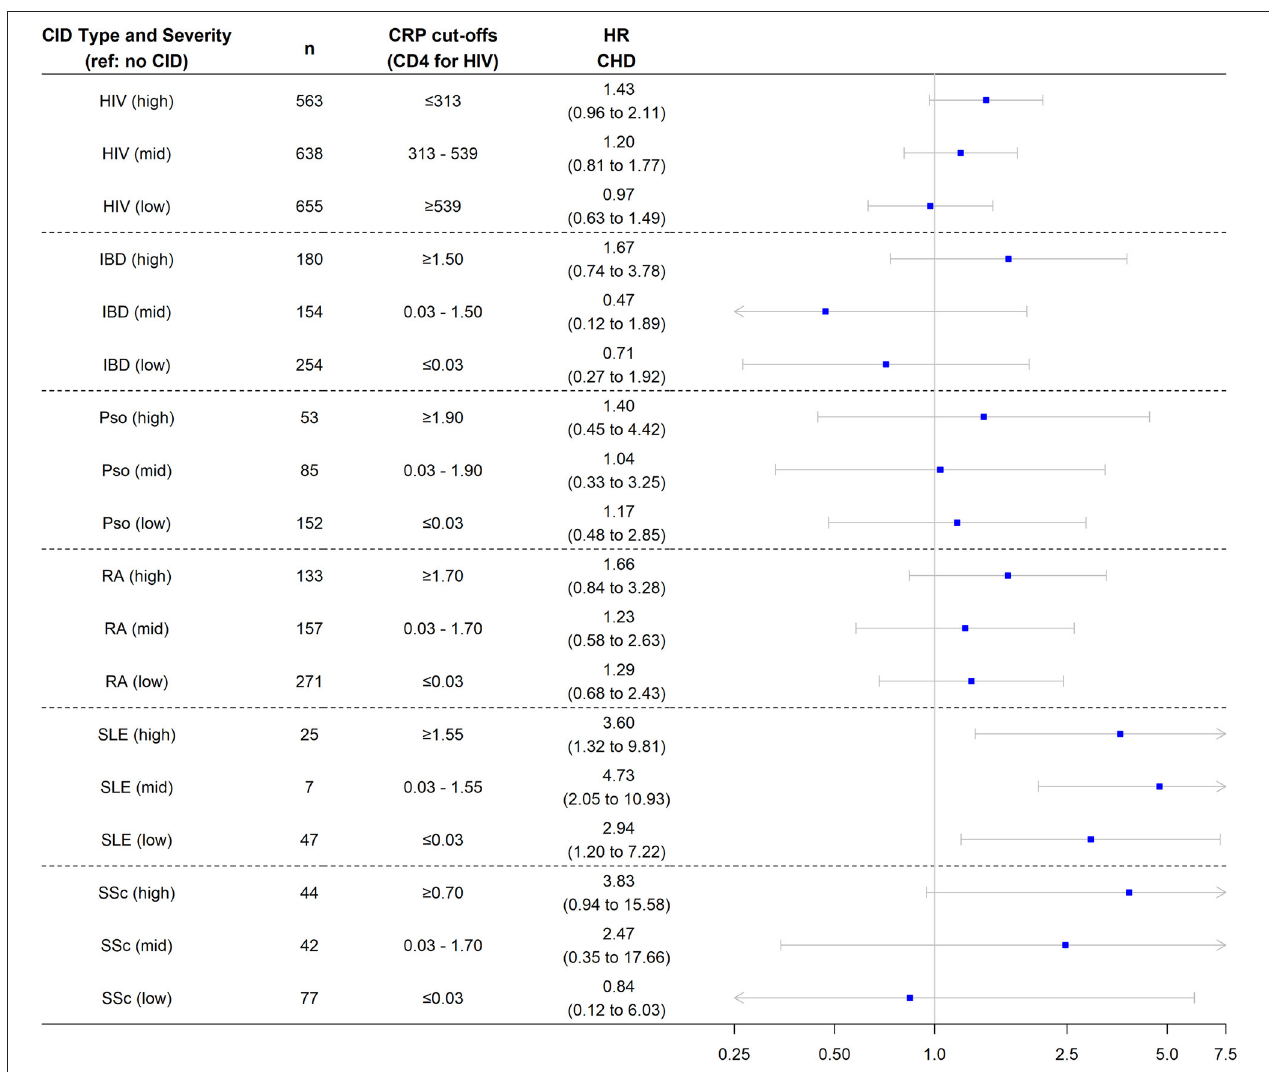
FIGURE 3 | Risk of incident coronary heart disease among chronic inflammatory disease groups stratified by disease severity. Analysis performed in nested cohort. Cox proportional hazard ratios adjusted for age, sex, race/ethnicity, insurance, baseline year, hypertension, diabetes, current smoking, total cholesterol, statin use, and systemic steroid use. CHD, coronary heart disease; HR, hazard ratio; CID, chronic inflammatory disease; HIV, human immunodeficiency virus; RA, rheumatoid arthritis; SLE, systemic lupus erythematosus; SSc, systemic sclerosis; IBD, inflammatory bowel disease.